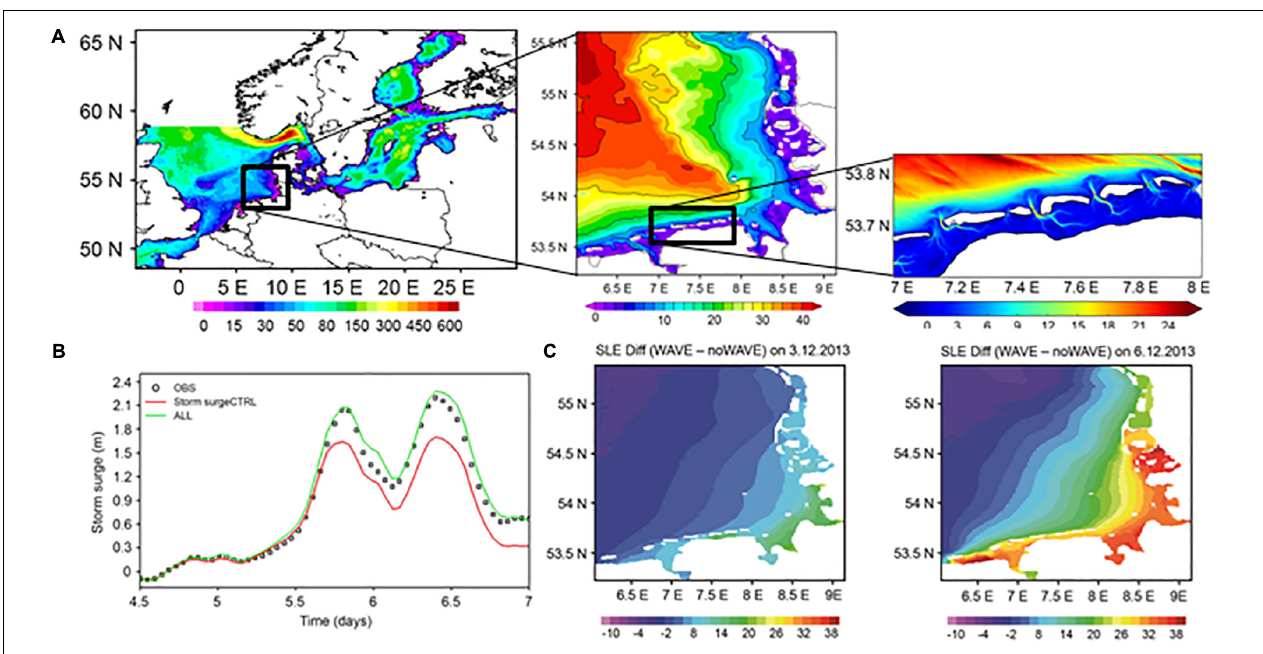
FIGURE 5 | (A) Bathymetry of the nested grid model domains for the North Sea (left pattern), German Bight (middle pattern), and the east Wadden Sea (right pattern). The spatial resolution is 3 nm, 1 km, and 200 m, respectively. (B) Observed (black squares) against computed storm surges for the circulation model only (red line) and the coupled wave-circulation model (green line) during storm Xavier at station Helgoland. The X -axis corresponds to the time in days from December 1, 2013. (C) Sea level elevation (SLE) difference (cm) between the coupled wave–circulation model and circulation-only model for the German Bight on December 3, 2013 at 01:00 UTC (left) and during the storm Xavier on December 6, 2013 at 01:00 UTC (right). Adapted with permission from Staneva et al. (2016a,